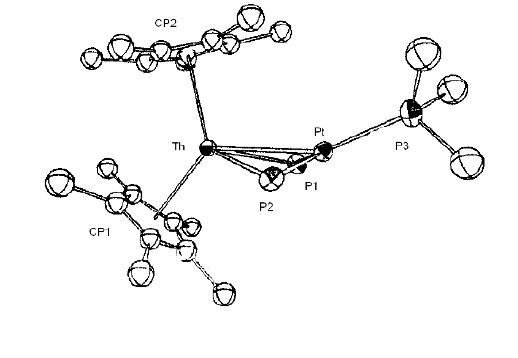
Figure 10. Structure of (Me